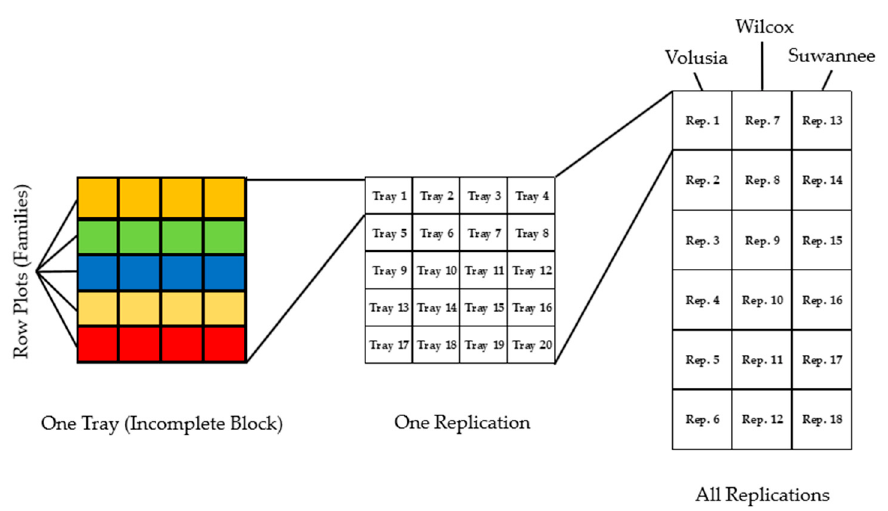
Figure 1. A graphic representation of the experiment design. Each tray is designed as an incomplete block with five four-tree row plots. Each replication had 20 such trays (i.e., 20 incomplete blocks). Each of these replications was assigned to one of three isolate